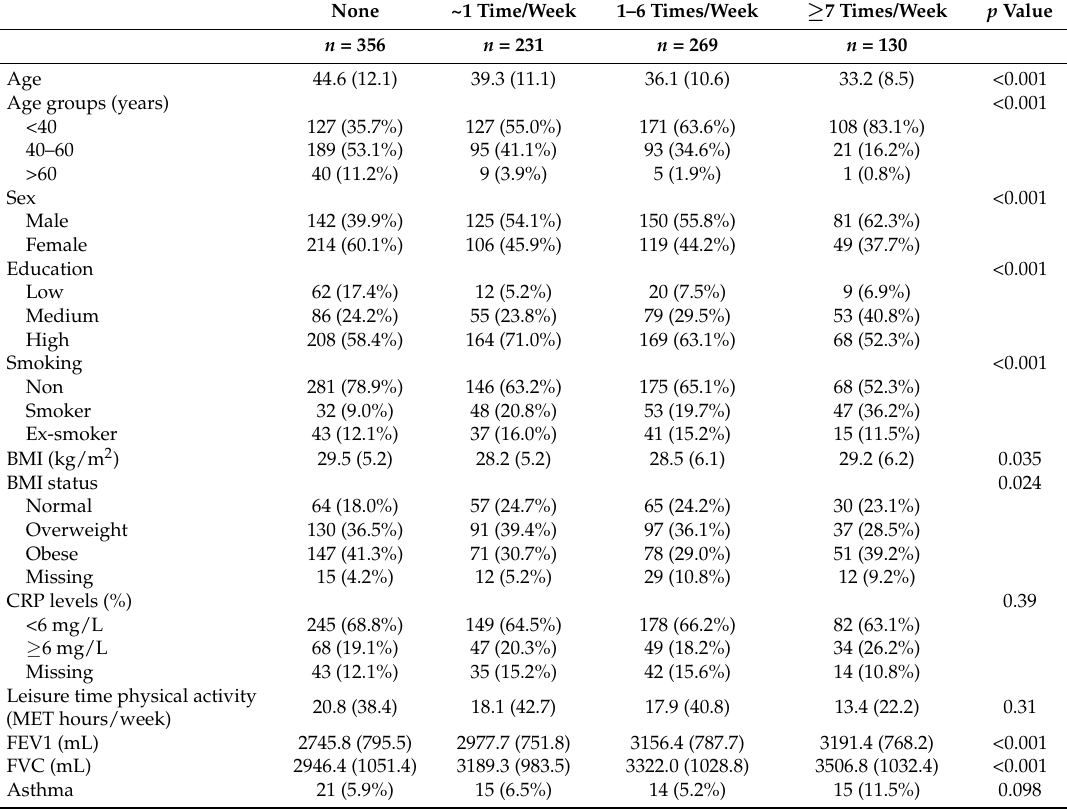
Table 1. Sample characteristics by soft drink consumption among participants attending Qatar Biobank study ( n = 986).